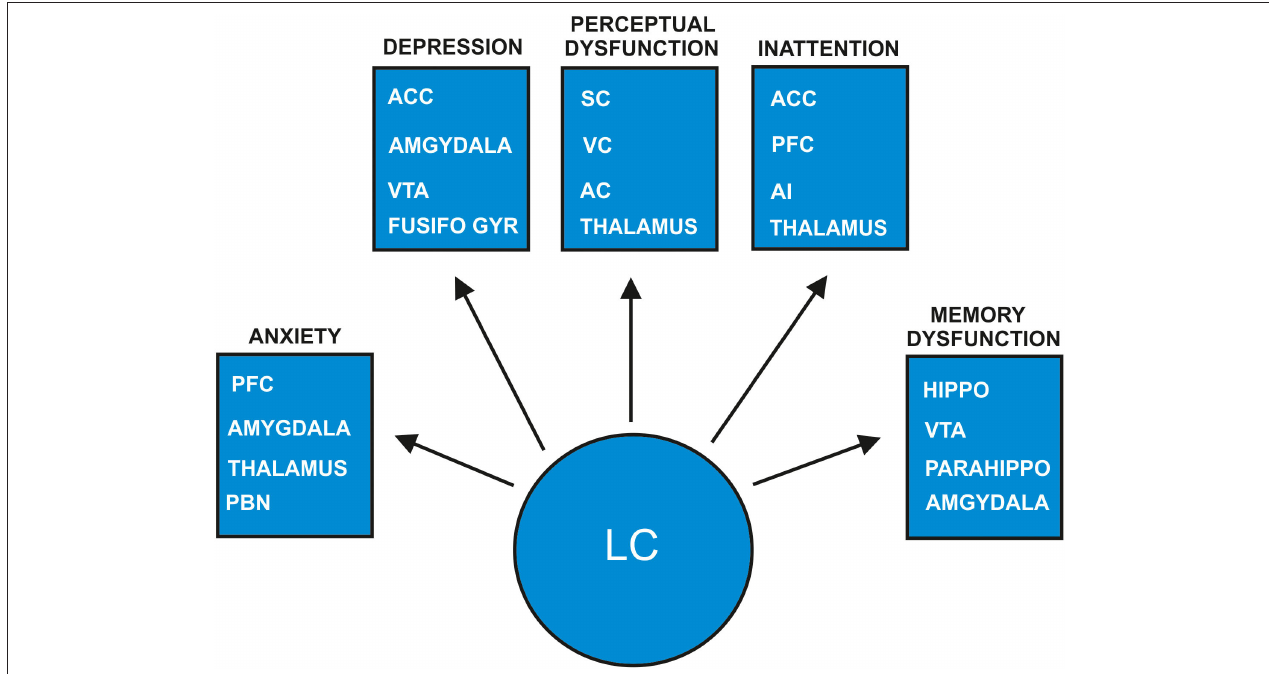
FIGURE 1 | Proposed model of how psychiatric symptoms develop in prodromal dementia with Lewy bodies due to locus-coeruleus degeneration. The arrows depict the projection areas in the locus coeruleus (LC) noradrenaline system are suspected to be involved in the genesis of psychiatric symptoms as anxiety, depression, perceptual dysfunction, inattention and memory dysfunction. The indicated specific neuronal pathways for each psychopathologic category such as anxiety, depression, perceptual dysfunction, inattention and memory dysfunction are supposed to be degenerated due to early LC affection in prodromal DLB patients. AC, auditory cortex; ACC, anterior cingulate cortex; AI, anterior insula; Fusifo Gyr, fusiform gyrus; Parahippo, parahippocampal gyrus; PBN, parabrachial nucleus; PFC, prefrontal cortex; SC, somatosensory cortex; VC, visual cortex; VTA, ventral tegmental